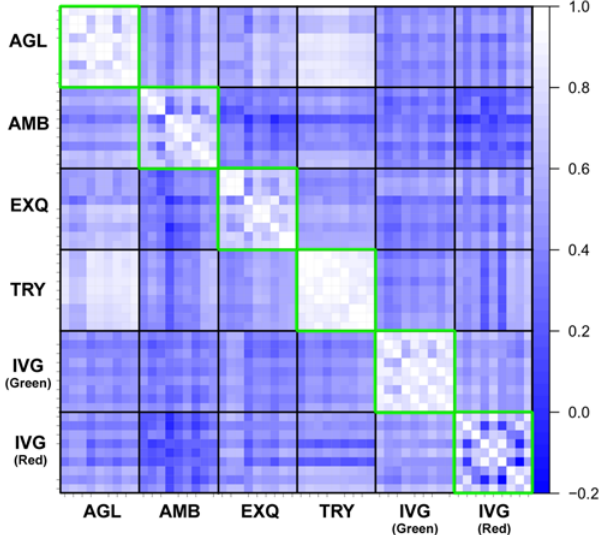
Figure 3. Rank correlation of log-ratios between intra- and inter-platform replications. For each platform, microRNA expression profiles in the liver and the prostate were measured three times by independent microarray chips. Therefore, 9 (=3 6 3) combinations of log-ratios (liver/prostate) for each microRNA was calculated. Then, 81 (=9 6 9) Spearman’s correlation coefficients (Rs) values were calculated, and visualized in blue-white heat map. White indicates high correlation, whereas blue means low correlation. Heatmaps by Pearson’s and Kendall’s correlation coefficients were available in Figure S4. replicates of the same sample type was calculated on each platform (line graphs in Figure 4A). As expected, microarray signals from liver samples were generally weaker than those of prostate samples (Figure 1). Thus, the percent of detected microRNA subset in liver samples was significantly smaller than that in prostate samples (Figure 4A, paired T-test: p = 0.0003, and Wilcoxon’s signed rank test: p = 0.0005). In the current study, we used criteria of detection call of microRNAs that the manufacturers recommended.